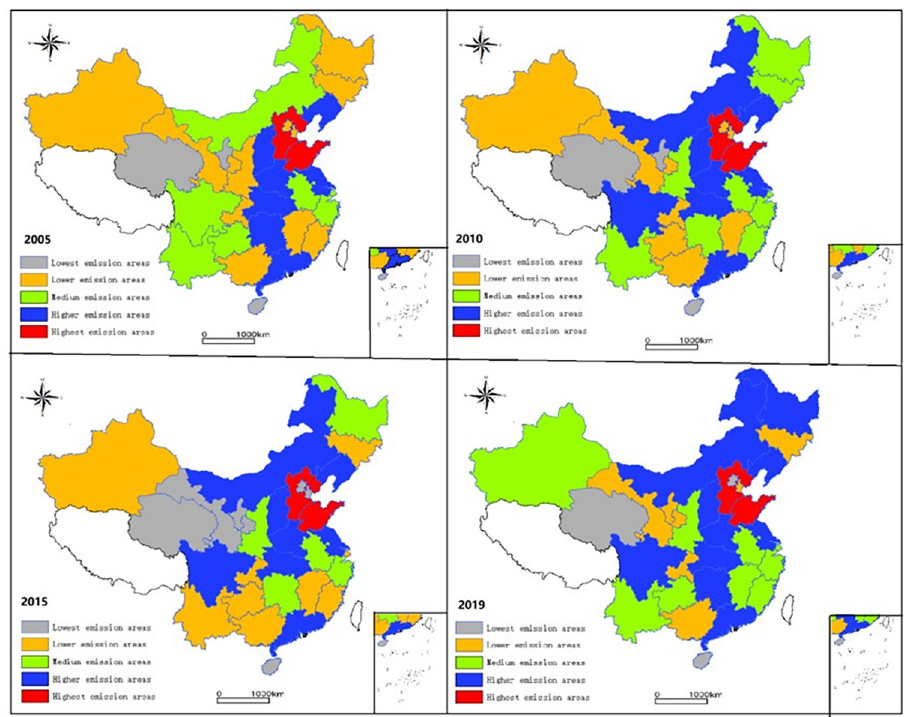
Fig 3. Visualization results of spatial differentiation pattern of regional carbon emissions. (Note: The original picture is from Natural Earth, http://www.naturalearthdata.com).